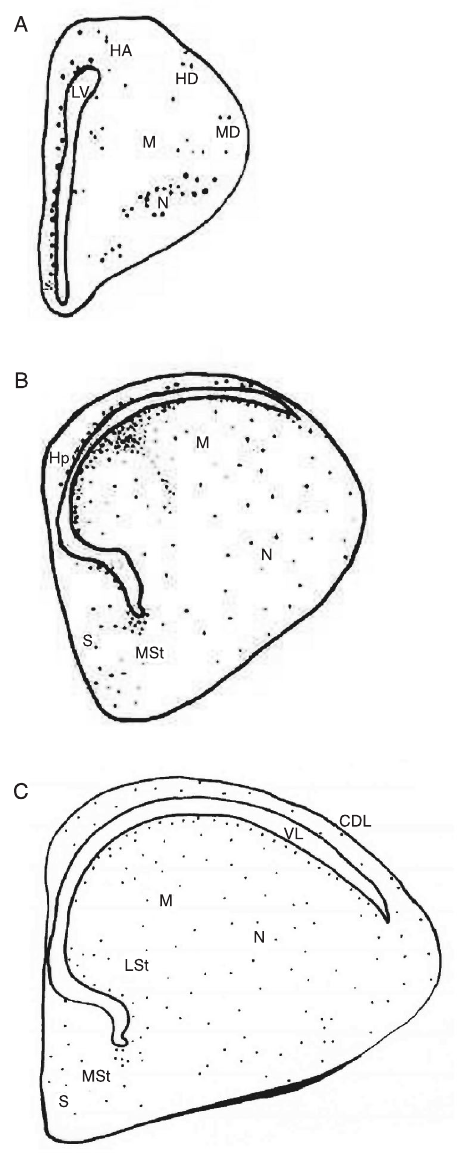
Figure 1. Schematic drawing of coronal sections of the chick embryo telencephalon showing the location of lectin-reactive cells (points). A , (E7) rostral